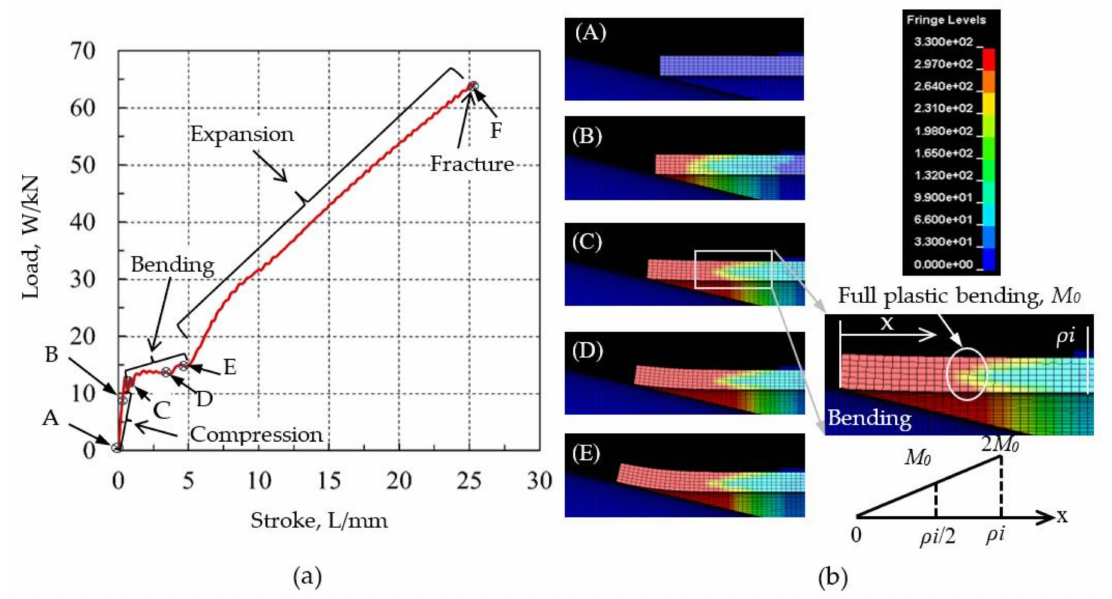
Figure 4. Load–stroke curve and effective stress distribution of tube end in the flaring test ( α = 30 ◦ ). ( a ) the load–stroke curve; ( b ) the effective stress